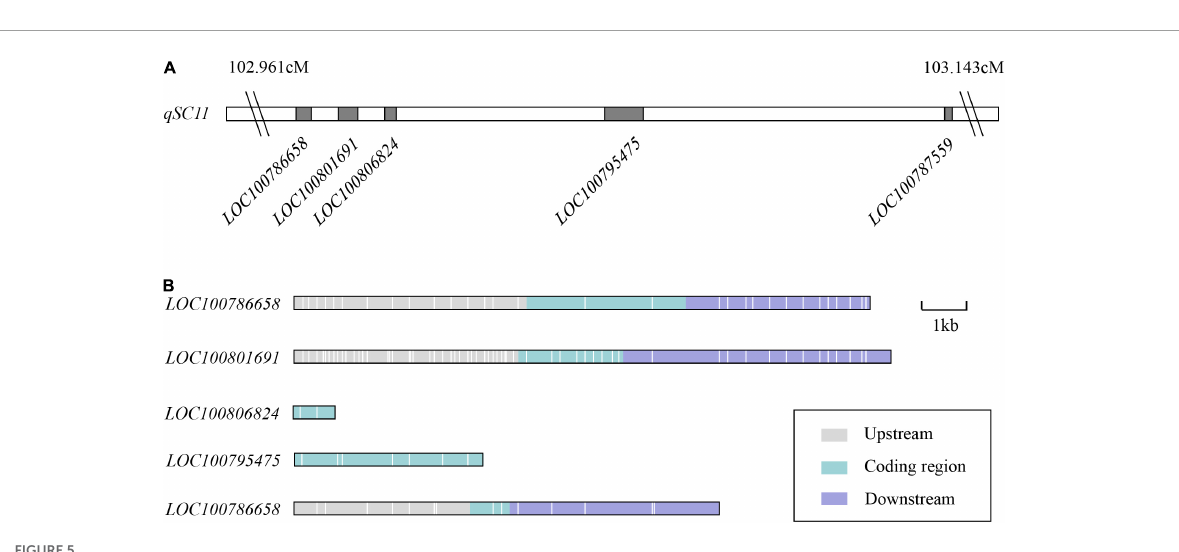
FIGURE5 Distribution of the five candidate genes for seed coat color on qSC11 . (A) Distribution of the candidate genes on qSC11 . (B) Variation distribution of the candidate genes on qSC11 . The upstream and downstream represent the 5 kb within the region of transcription start and stop sites, respectively. The regions are markers of different colors. Each white line represents one SNP/InDel